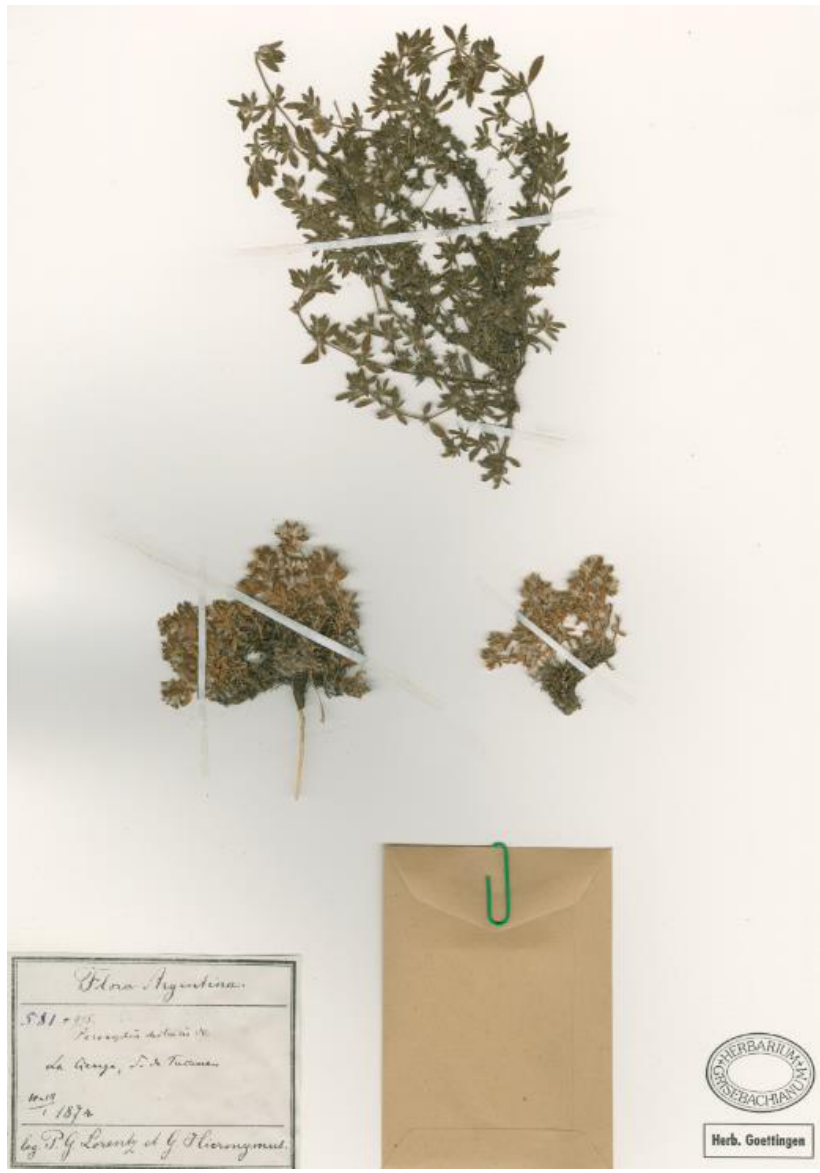
Figure 8. Lectotype of the name Paronychia hieronymi (GOET!).